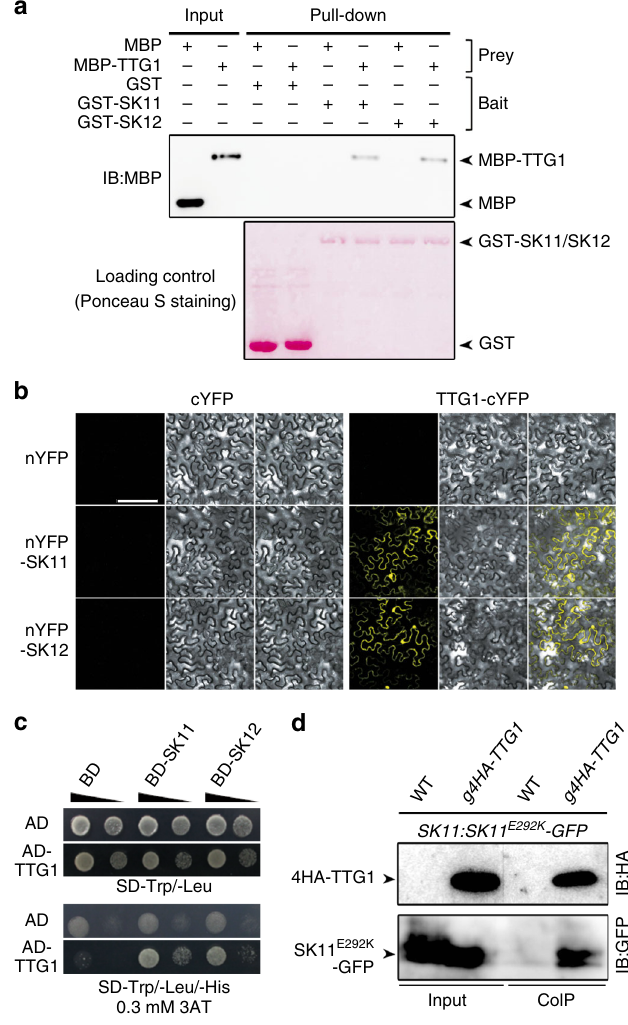
Fig. 1 SK11 and SK12 interact with TTG1. a GST pull-down assay of the interaction of TTG1 with SK11 and SK12. GST, GST-SK11, and GST-SK12 were used as baits, and their loading amounts stained with Ponceau S are shown in the bottom panel. The input of prey proteins, MBP and MBP-TTG1, and their corresponding pull-downed signals are shown in the upper panel. b BiFC analysis of the interaction between TTG1 and SK11/SK12 in tobacco epidermal cells. Scale bar, 200 μ m. c Yeast two-hybrid assay of the interaction between TTG1 and SK11/SK12. Ten-fold serial dilutions of transformed yeast cells were grown on SD-Trp/-Leu medium (upper panel) and SD-Trp/-Leu/-His medium supplemented with 0.3 mM 3-amino-1, 2, 4-triazole (3AT) (lower panel). d In vivo interaction between 4HA-TTG1 and SK11 E292K -GFP in Arabidopsis siliques shown by co- immunoprecipitation (CoIP). Total protein extracts from siliques of SK11: SK11 E292K -GFP in wild-type (WT) or g4HA-TTG1 background 4 days after pollination (DAP) were immunoprecipitated by anti-HA antibody. The input and co-immunoprecipitated proteins were subjected to immunoblot analysis with anti-HA (upper panel) or anti-GFP antibody (lower